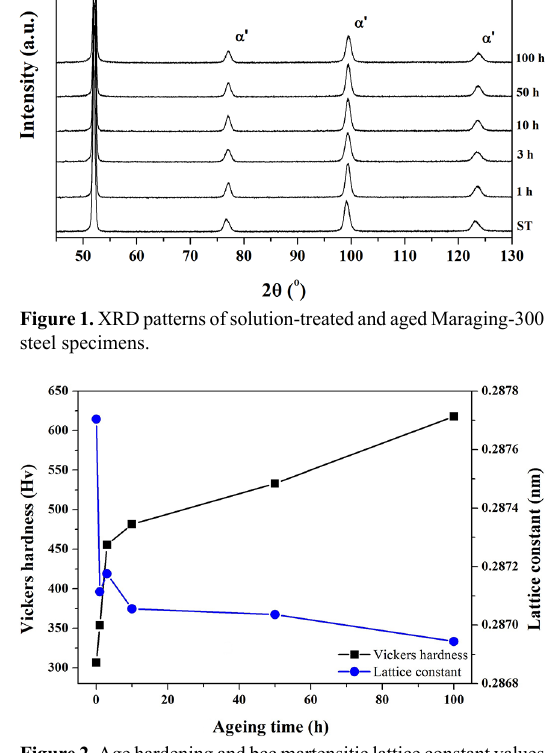
Figure 2. Age hardening and bcc martensitic lattice constant values of solution-treated and aged Maraging-300 steel